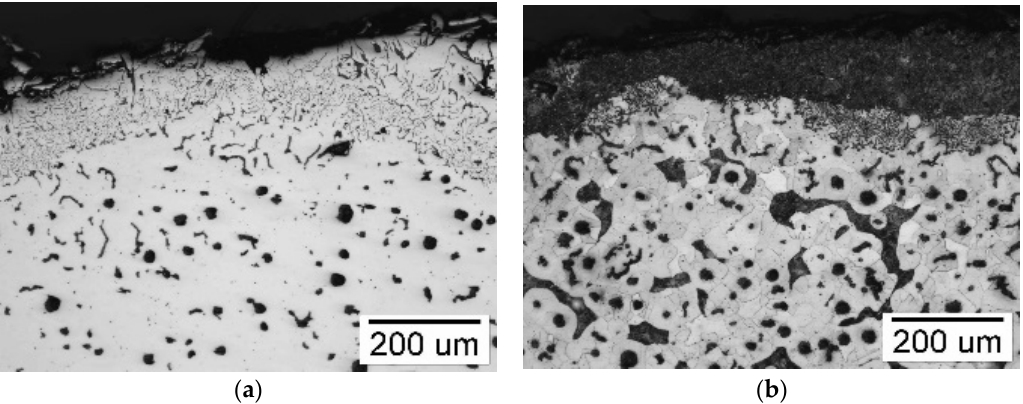
Figure 8. Unetched ( a ) and Nital-etched ( b ) casting surface structure, at larger pictures (S-bearing coating).